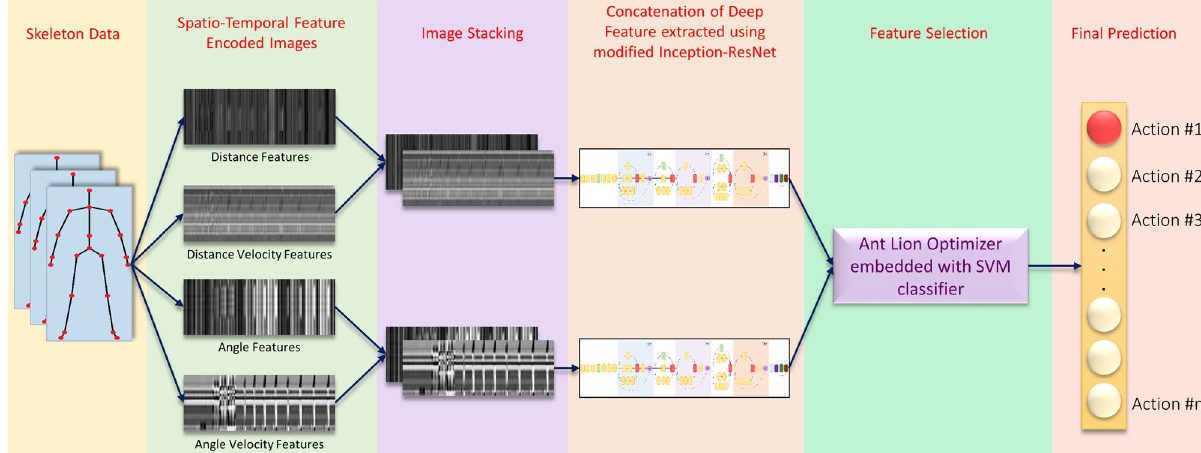
Figure 1. Overall workflow of the proposed DSwarm-Net model for solving 3D HAR